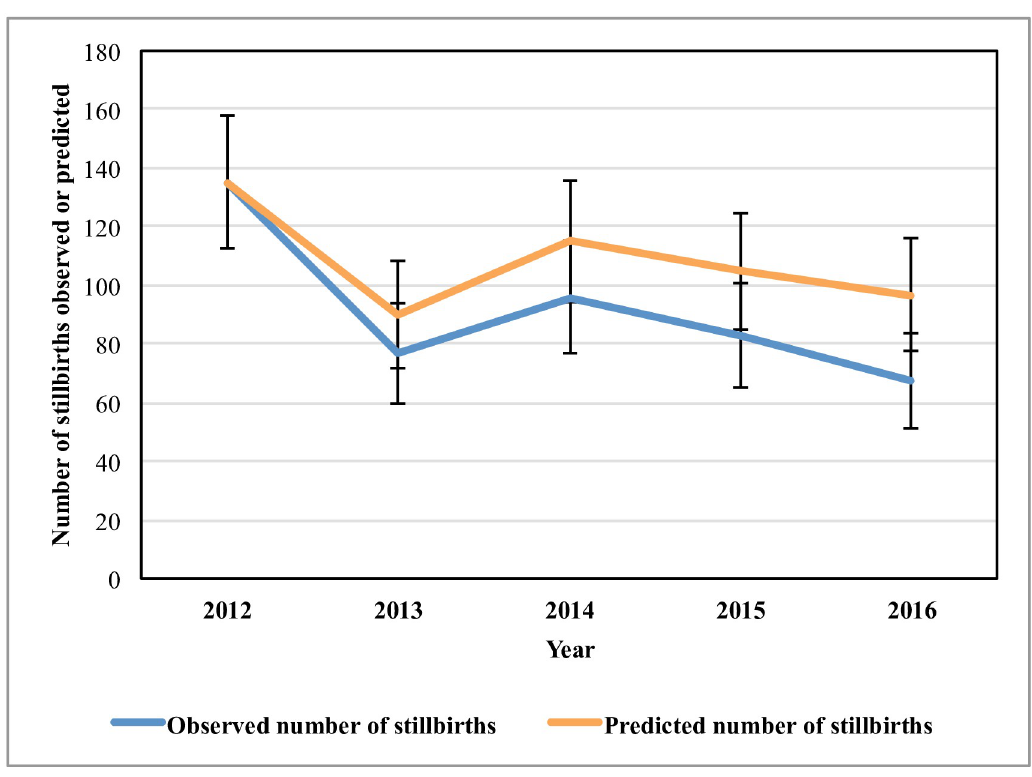
Fig 2. Stillbirths predicted to have occurred, by steady-state assumption.